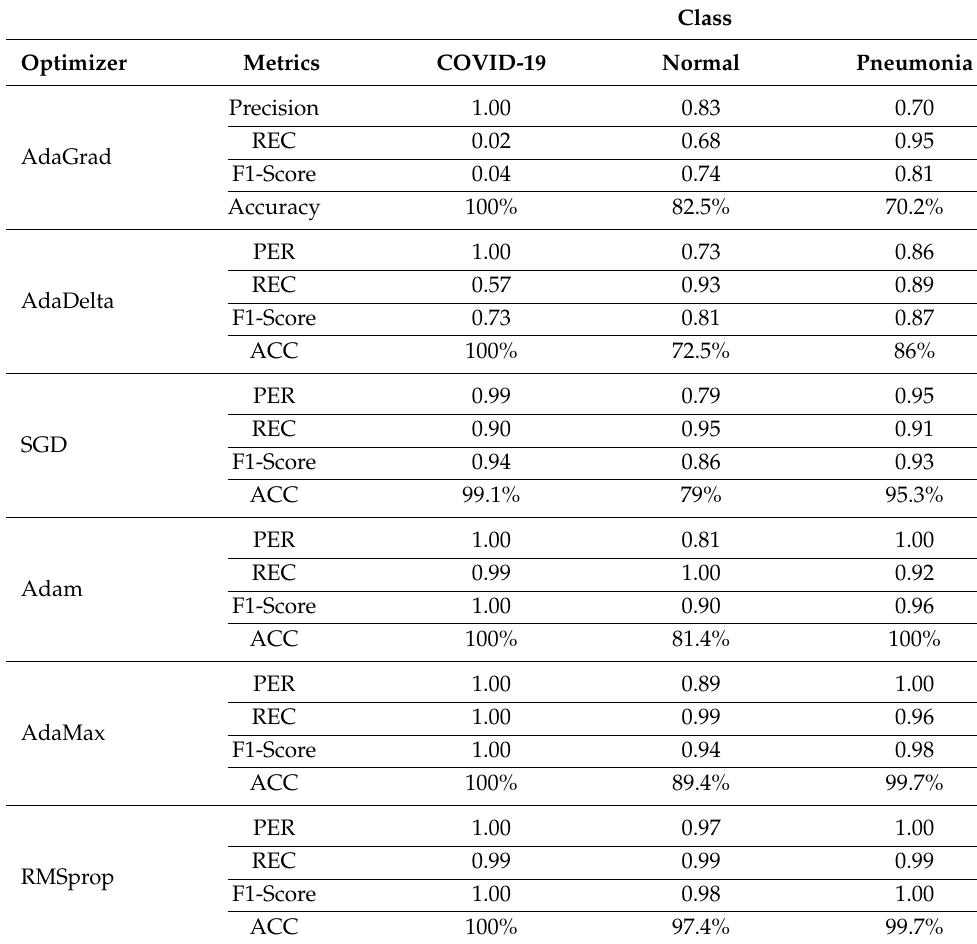
Table 3. Comparative analysis of each class and overall accuracy using different optimizers with the LeakyReLU activation function set at α =